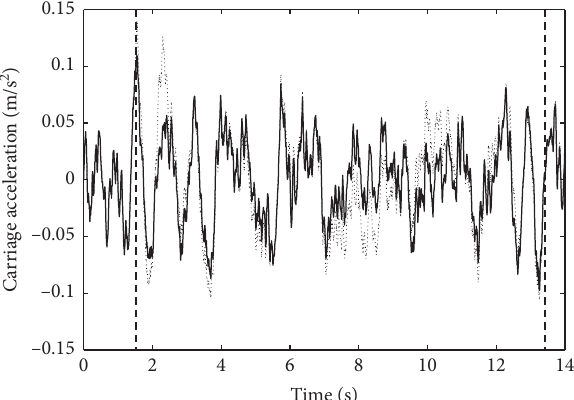
Figure 5: Effects of tunnel differential settlement on vertical ac- celeration of the first carriage ( without differential settlement; with differential settlement; the moment when the train enters or leaves the settlement